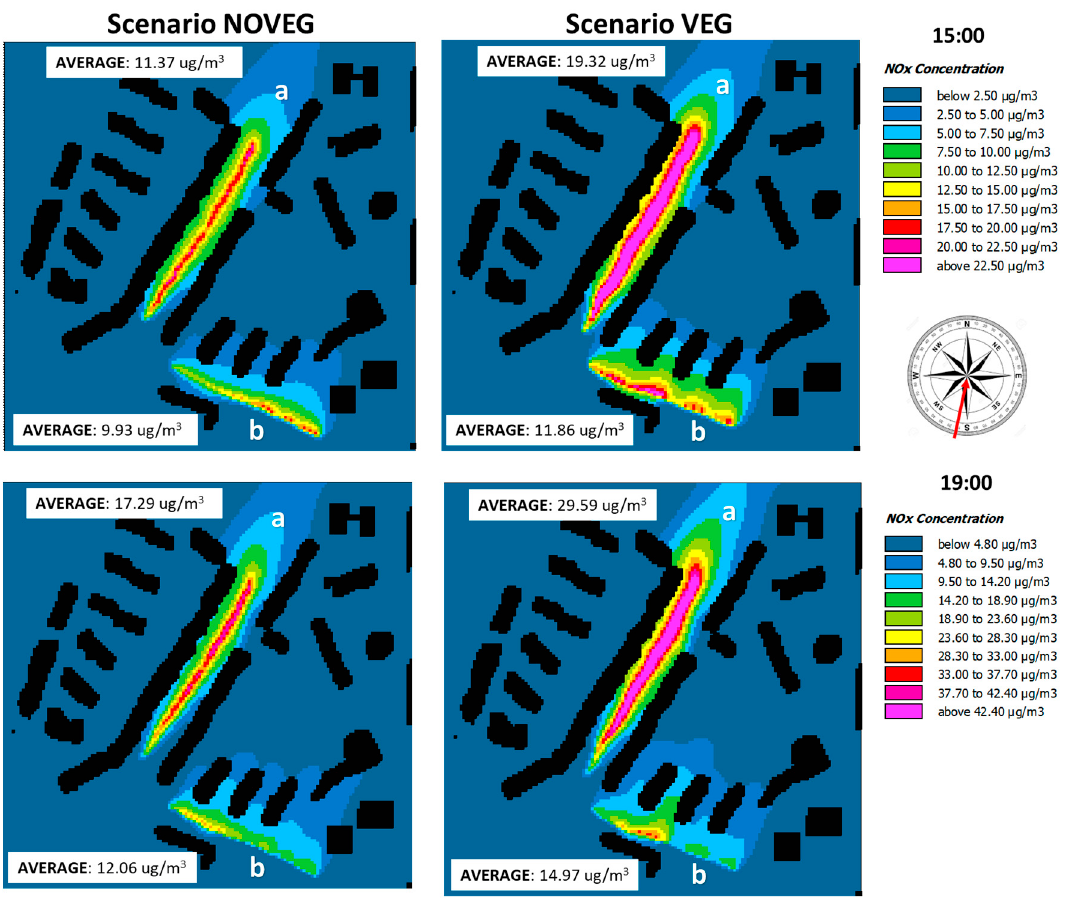
Figure 8. NOx concentration maps obtained from ENVI-met at 3:00 p.m. on 7 July 2019 at pedestrian height for the scenario without vegetation (NOVEG) and with vegetation (VEG) in street canyons “a” and “b”, with indication of the spatially averaged canyon concentrations. The wind rose indicates the wind direction (red) of 210°.